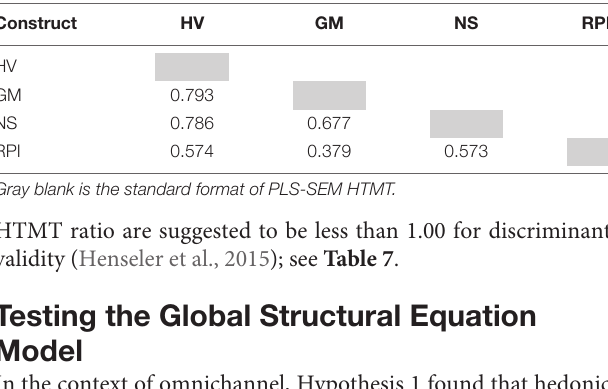
TABLE 7 | Heterotrait-Monotrait ratio (HTMT) for discriminant validity.